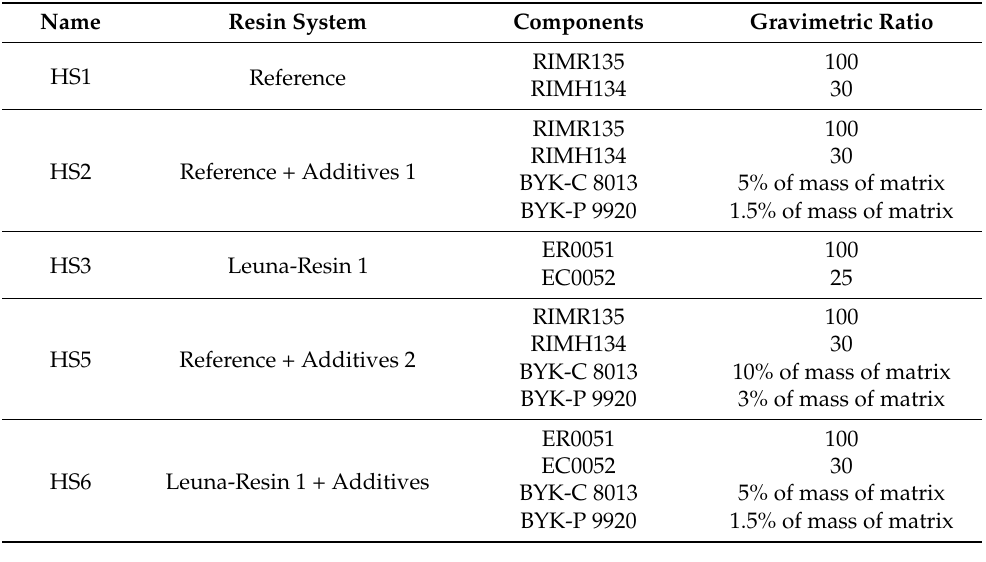
Table 1. Repair resin systems.